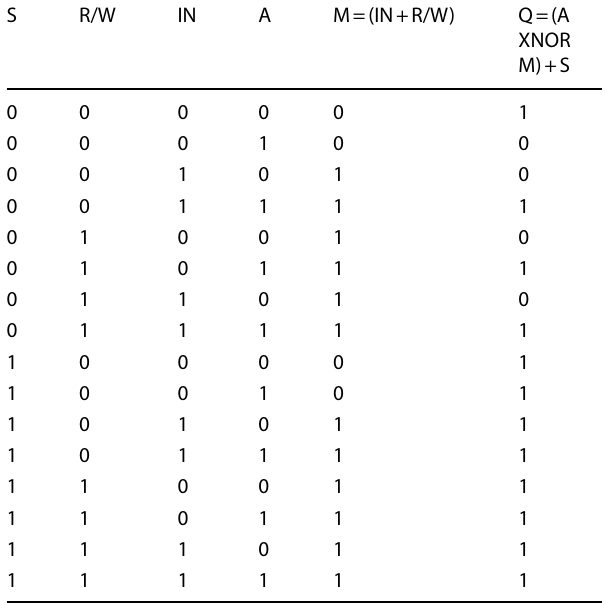
Table 2 The truth table for the proposed CAM circuit